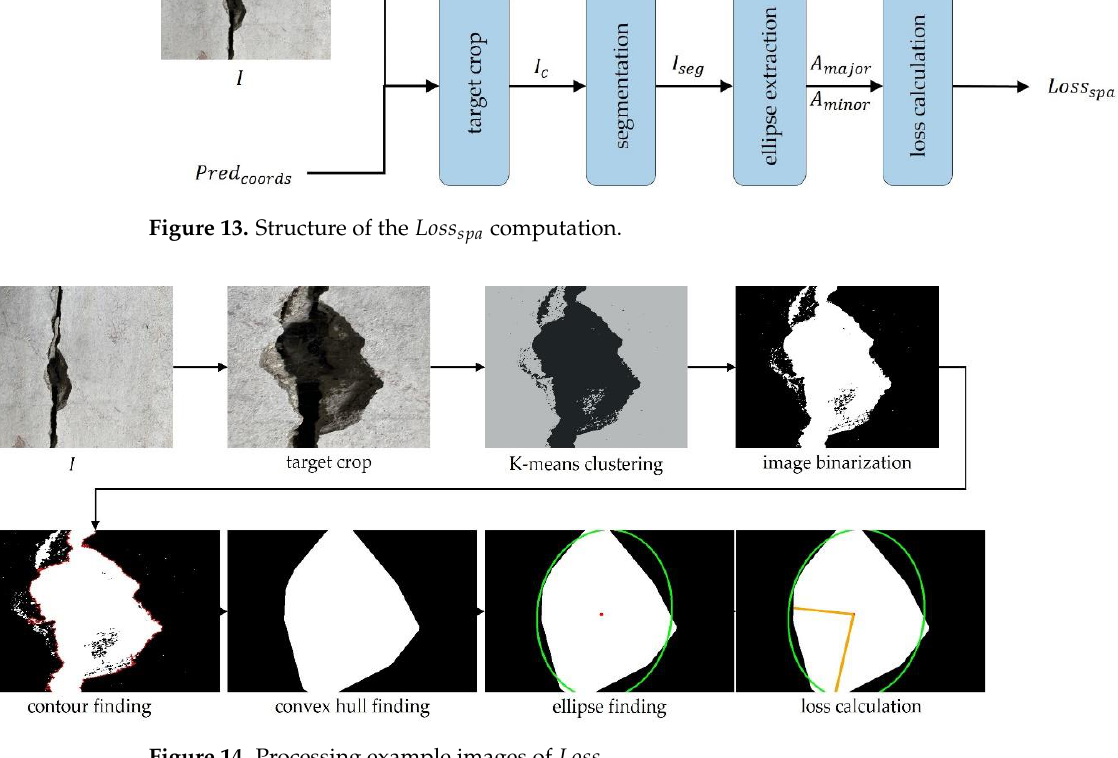
Figure 14. Processing example images of 𝐿𝑜𝑠𝑠 𝑠𝑝𝑎 .